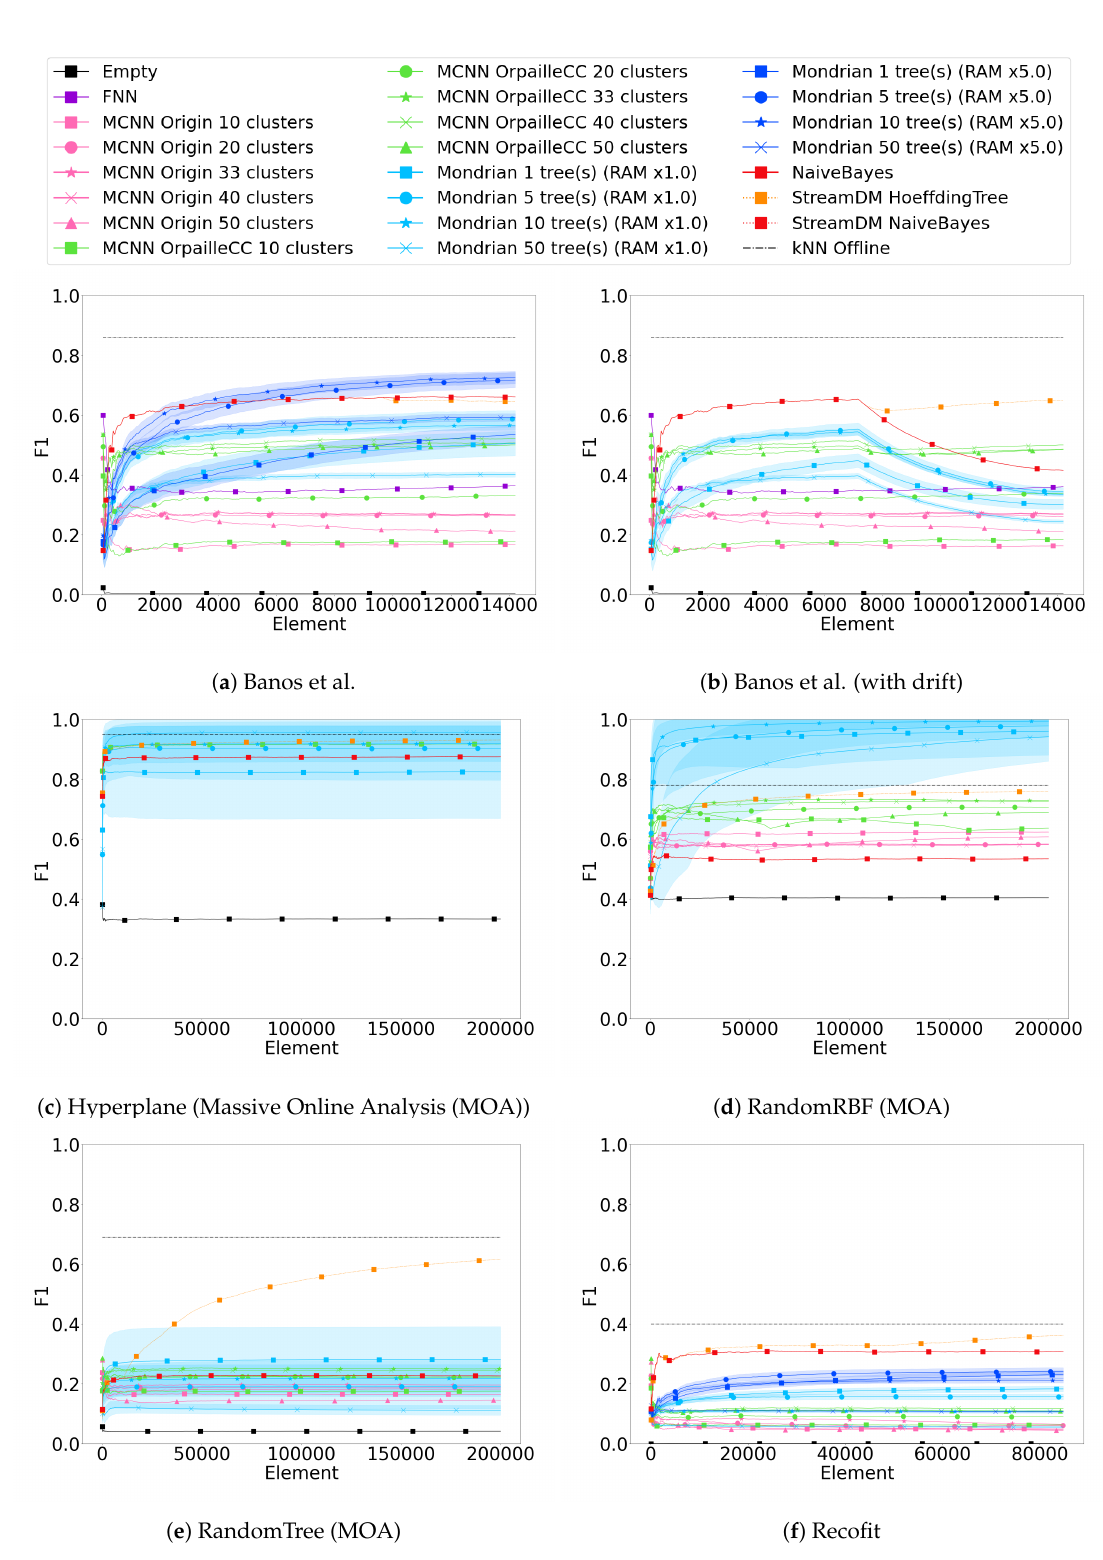
Figure 1. F1 scores for the six datasets (average over 20 repetitions). The horizontal dashed black line indicates the offline k-nearest neighbor ( k -NN) F1 score (the value of k was obtained by grid search in [2, 20]). The blue shades represent a ± σ interval of the Mondrian forest classifier across